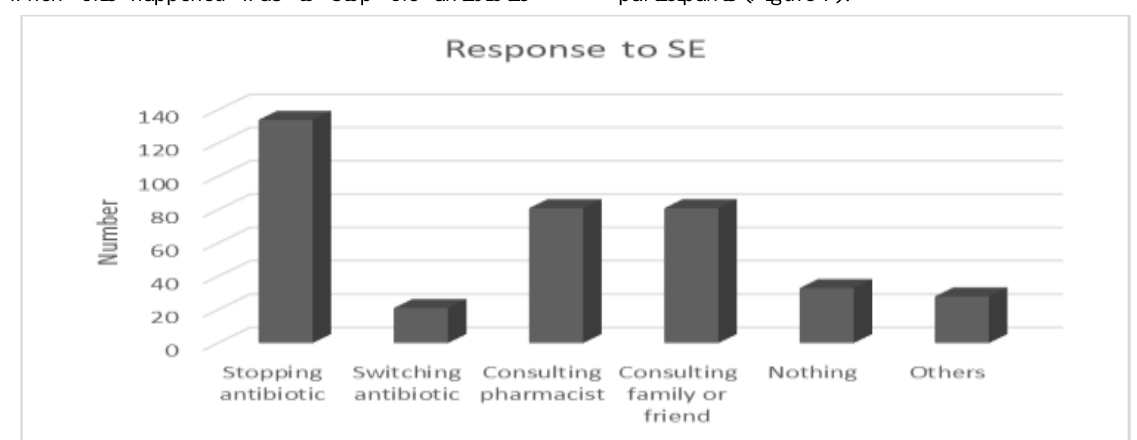
followed equally by consulting a pharmacist or a family or friend. Doing nothing and switching to another antibiotic were also recorded by some participants (Figure 7).